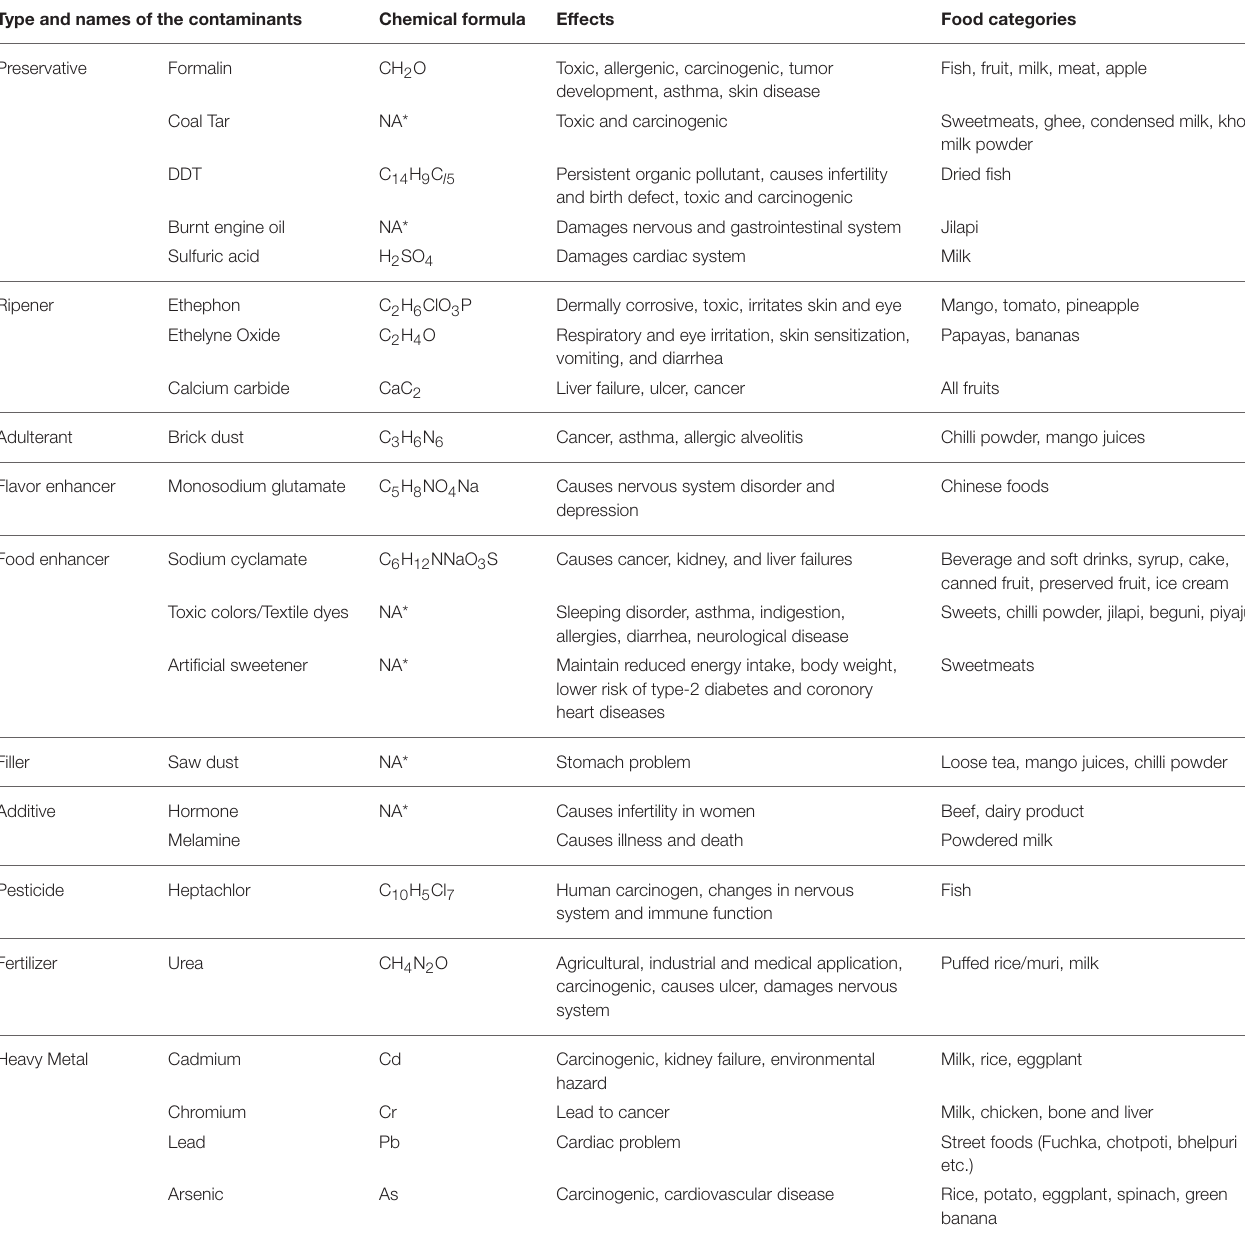
TABLE 1 | Common contaminants found in different categories of food in